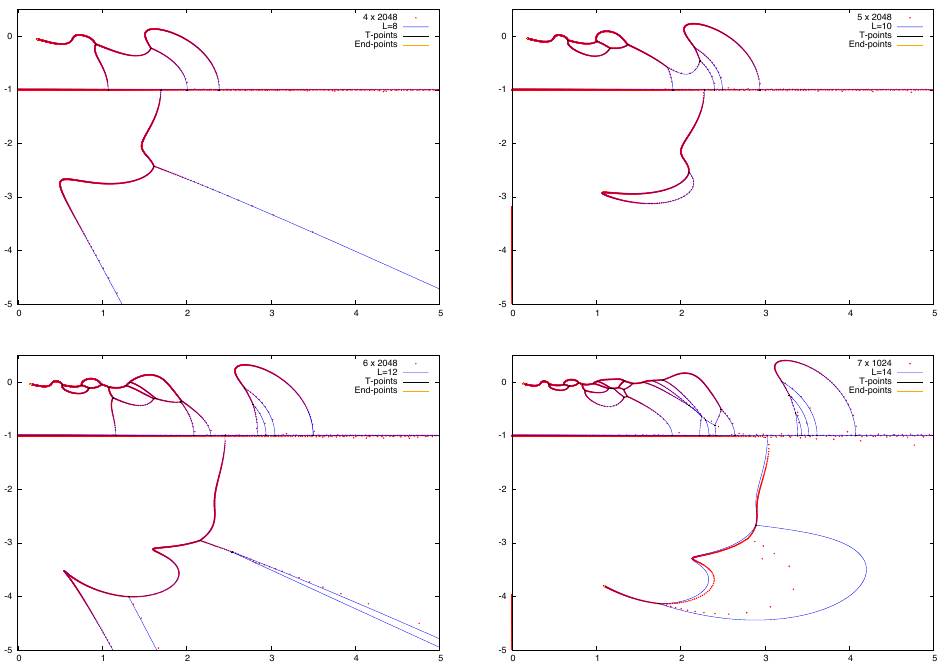
Figure 11 . Comparison between the partition function zeros on a (2 M + 1) (cid:2) 2 N cylinder, with M = 2048, and the corresponding condensation curves in the M ! 1 limit (closed channel). The panels show, in reading direction, the cases N = 4 ; 5 ; 6 ;